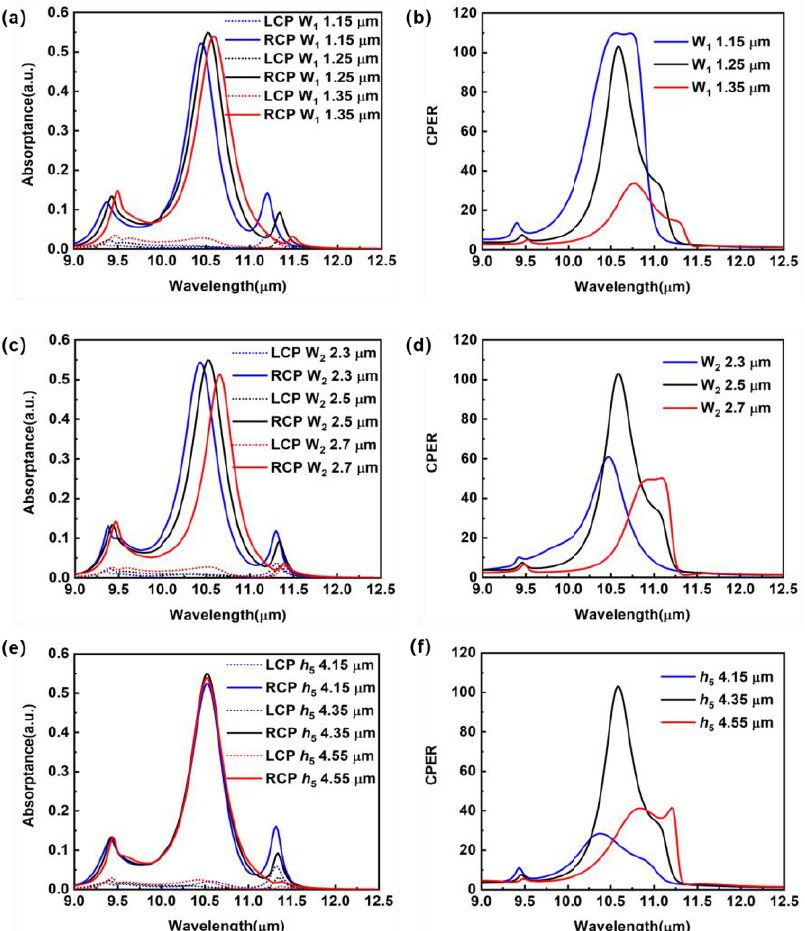
Figure 4. ( a ) Absorption efficiency spectra of the dielectric-metal-hybrid chiral metamirror integrated QWIPs with different W 1 values under RCP and LCP illumination. The rest of the geometrical parameters remain the same as for the device presented in Figure 1. ( b ) CPERs corresponding to the different W 1 values. ( c ) Absorption efficiency spectra of the devices with different W 2 values under RCP and LCP illumination. The other geometrical parameters remain the same as for the device presented in Figure 1. ( d ) CPERs corresponding to the different W 2 values. ( e ) Absorption efficiency spectra of the devices with different h 5 values under RCP and LCP illumination. The rest geometrical parameters remain the same as the device presented in Figure 1. ( f ) CPERs corresponding to the different h 5 values.